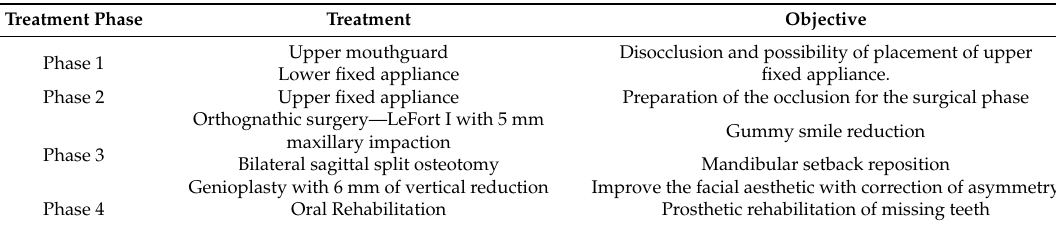
Table 2. Treatment plan of this case report.